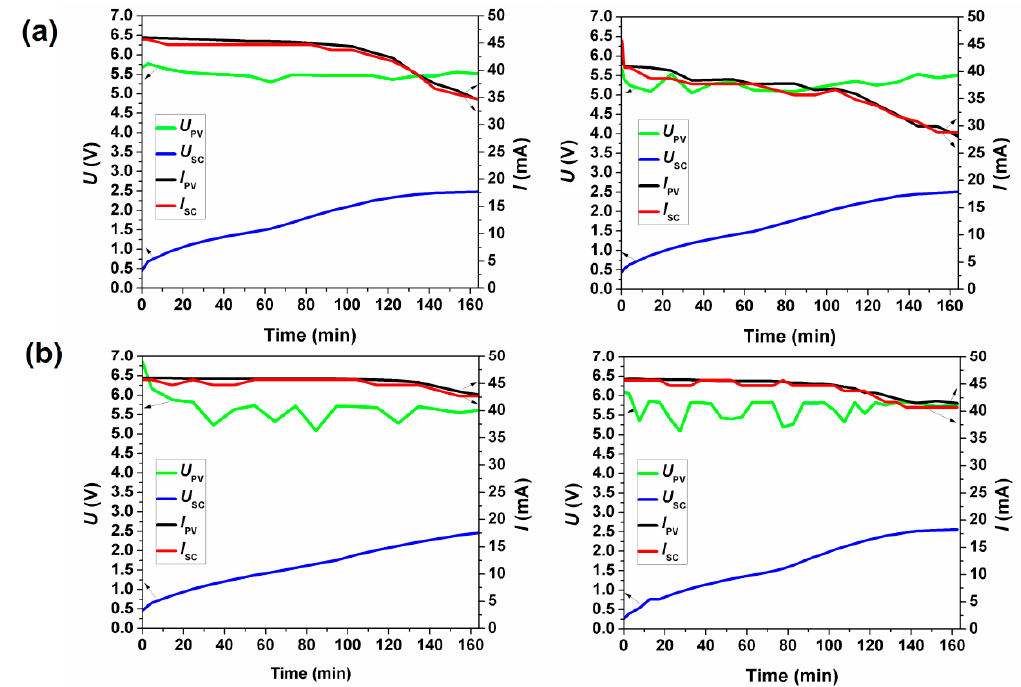
Figure 6. Charging characteristics of a supercapacitor charger model at 25 °C ( a ) and 15 °C ( b ) and illuminance of 1000 W m − 2 (left side) and 600 W m − 2 (right side), where U PV —voltage on the PV panel, I PV —current on the PV panel, U SC —supercapacitor voltage, I SC —supercapacitor current.